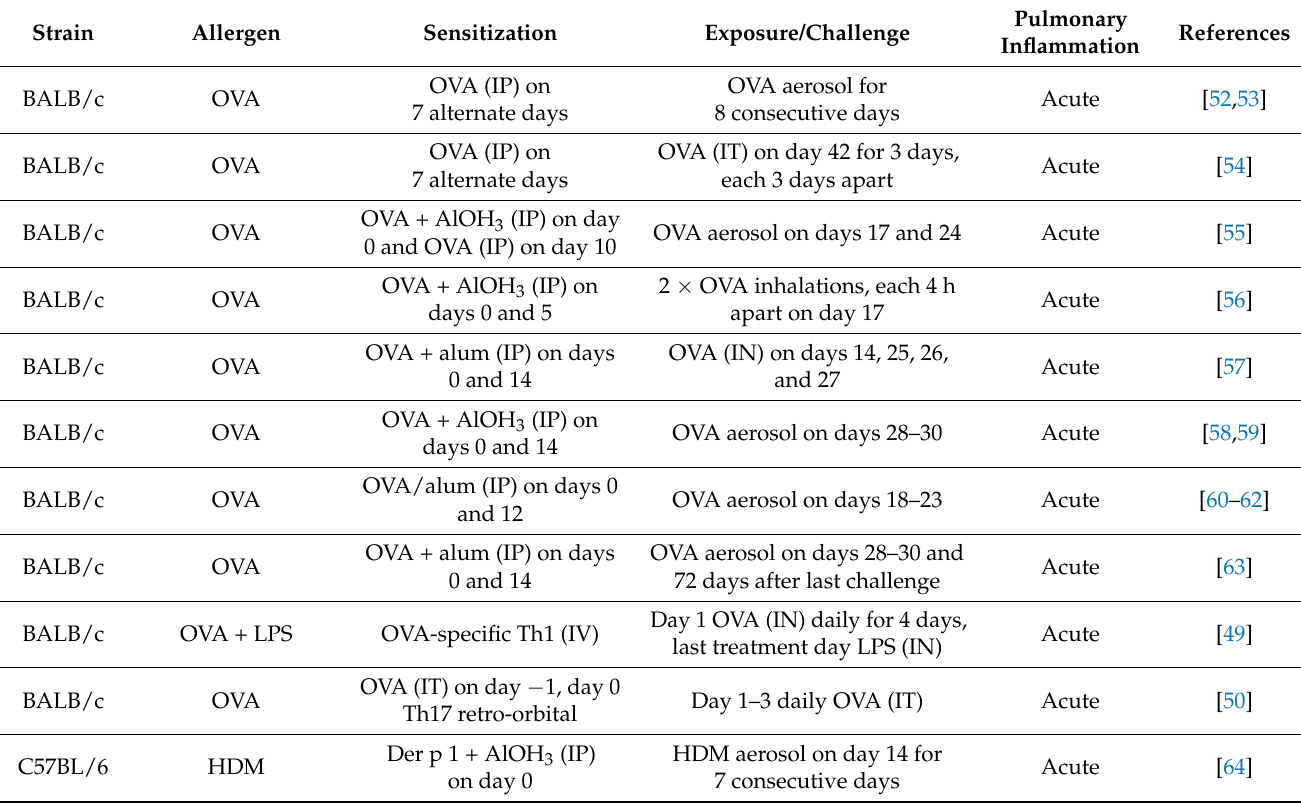
Table 1. Mouse models of asthma, acute versus